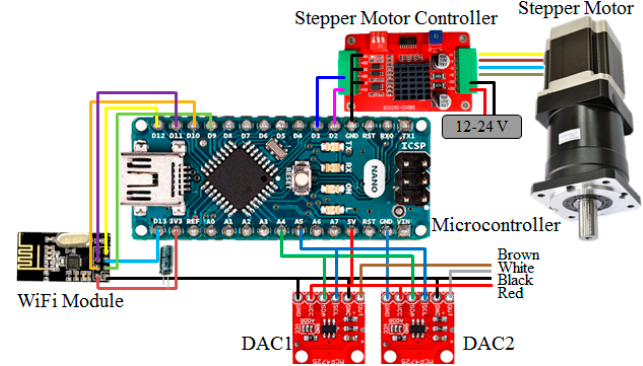
Figure 10. The schematic configuration of the vehicle control unit.